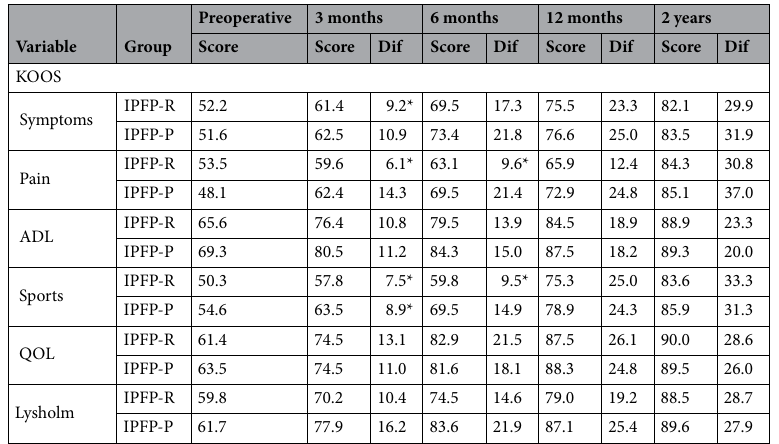
Table 2. Mean preoperative and postoperative scores with a mean change of scores from preoperative scores in both groups. Dif is a change of score from the preoperative score. No clinical improvement from the preoperative score. IPFP-R infrapatellar fat pad resection, IPFP-P infrapatellar fat pad preservation, KOOS knee injury, and osteoarthritis outcome score, ADL activities of daily living, BMI body mass index, QOL quality of life.